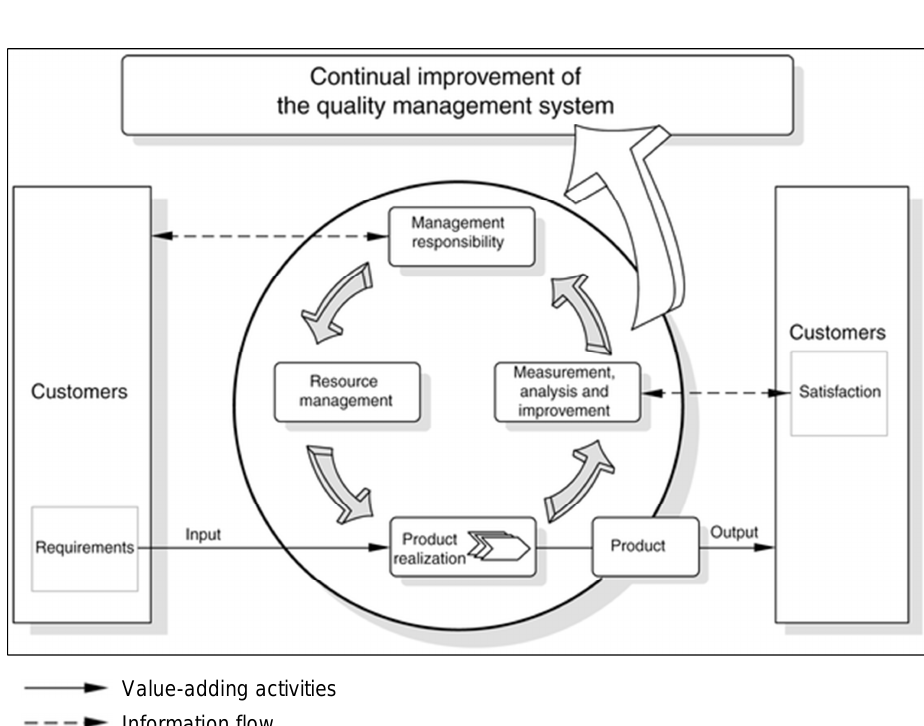
Figure 1 – Model of a process-based quality management system As per Figure 2, ISO 9001:2008 International Standard has achieved great international visibility with more than 1 Million Organizations with ISO 9001 certified Management Systems all over the world accordingly to ISO Survey 2013 (ISO,